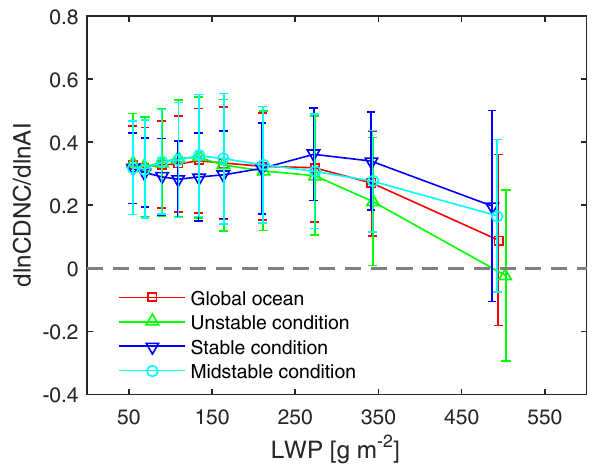
Figure 3. dlnCDNC / dlnAI obtained by linear regression of lnCDNC and lnAI under MODIS LWP bins. Red lines denote the global ocean. Green, blue, and cyan stand for unstable, stable, and midstable conditions, respectively. AI and CDNC are estimated from MYD04 and